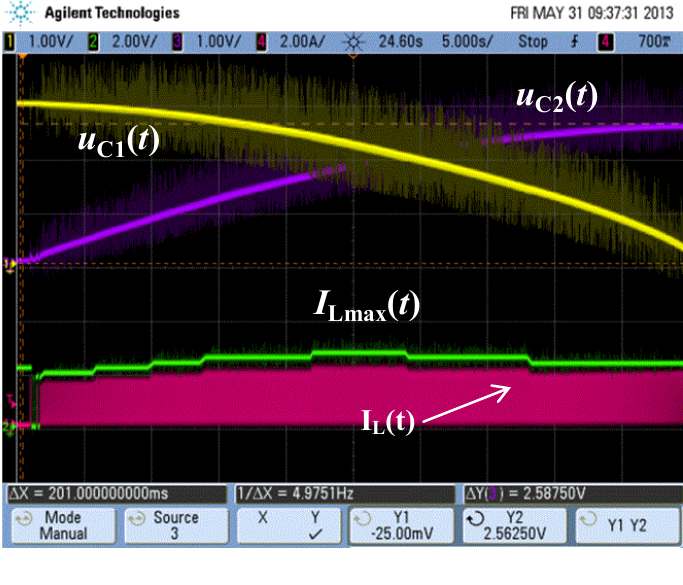
Figure 13. Experimental evolution of input and output voltages (optimum I